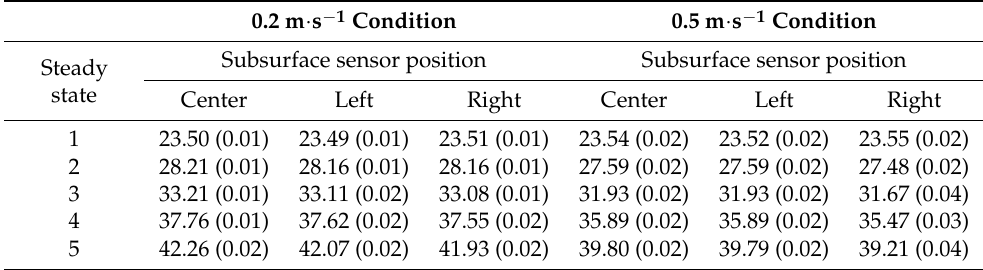
Table A1. Steady state mean temperatures ( ◦ C) for the directly subsurface temperature sensors during the uncovered experimental runs (bare model surface) under each air velocity condition (0.2 or 0.5 m · s − 1 ). Data are mean (SD) for n = 5